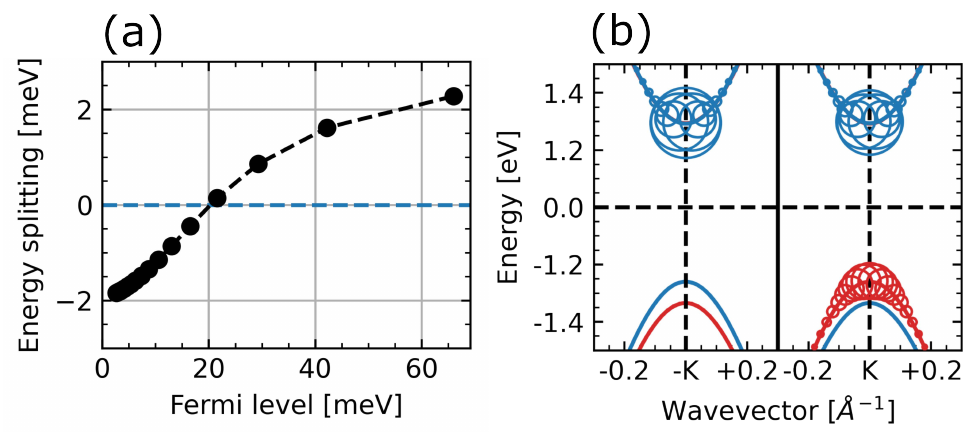
Figure A1. ( a ) Trion energy splitting between the lowest s z τ = ± 3/2 state and the lowest s z τ = ± 1/2 states of the freestanding of MoS2 monolayer. For a wide range of doping, the fully dark s z τ = ± 3/2 state will be the lowest trion state of the freestanding of MoS2 monolayer. ( b ) Contributions of the Dirac single-particle band states in the vicinity of the K and − K points to the lowest s z τ = ± 3/2 trion